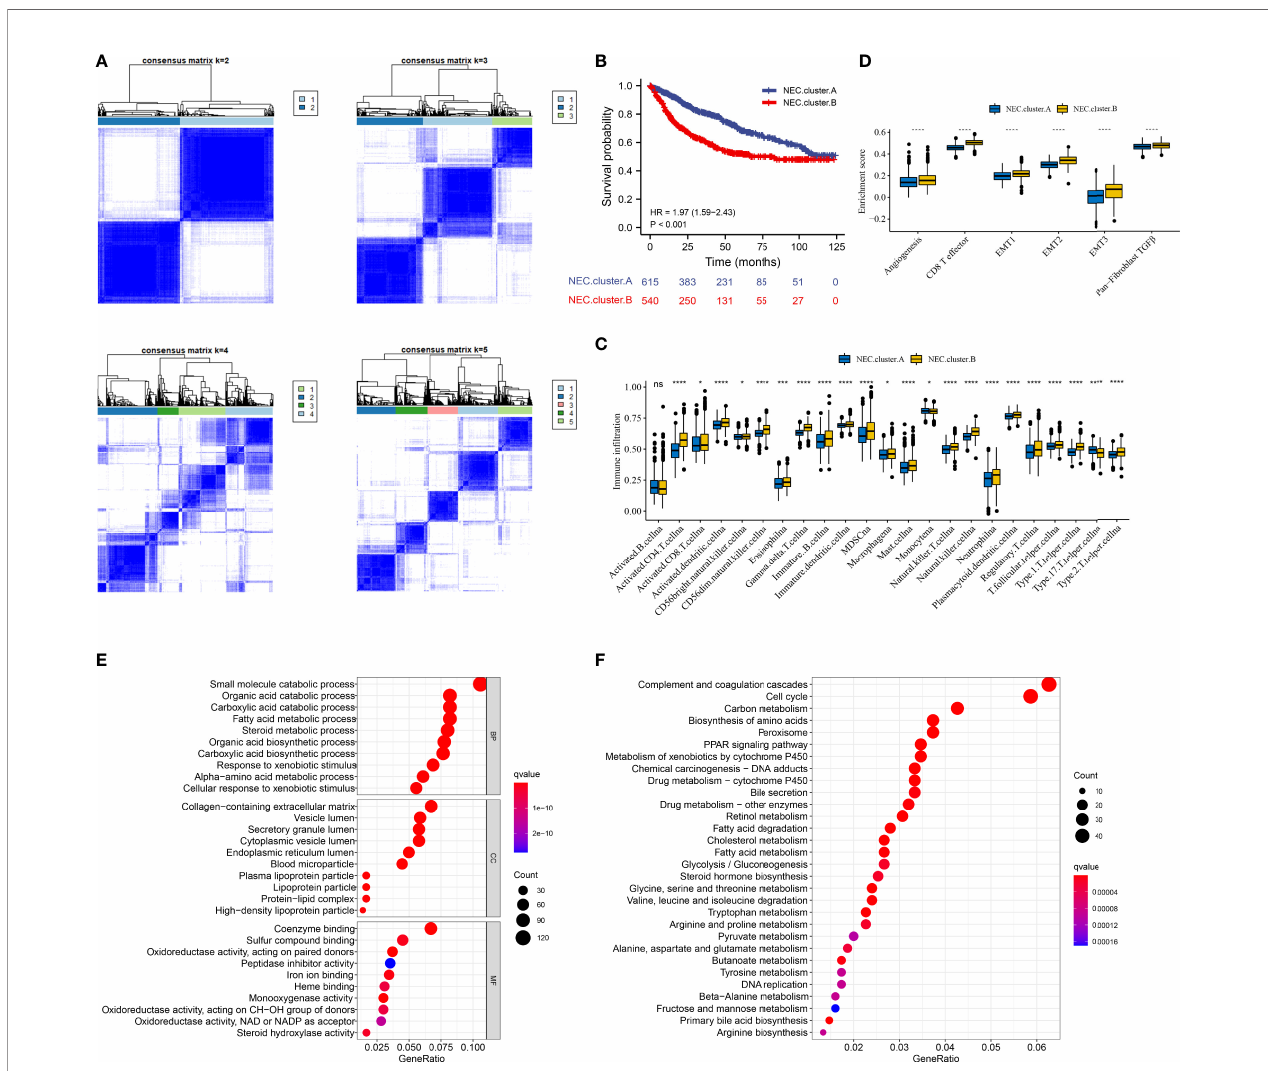
FIGURE 3 | Necroptosis subtypes and biological characteristics of two distinct subtypes of samples divided by consistent clustering. (A) Unsupervised consensus clustering for 1155 HCC patients in a meta cohort (TCGA-LIHC, LIRI-JP, GSE14520, GSE36376, and GSE76427). (B) Survival analyses for the two NEC.clusters based on 1155 patients with HCC from fi ve cohorts (TCGA-LIHC, LIRI-JP, GSE14520, GSE36376, and GSE76427) including 615 cases in NEC.cluster.A (blue), and 540 cases in NEC.cluster.B (red). Kaplan-Meier curves with Log-rank p value < 0.001 showed a signi fi cant survival difference among two modi fi cation patterns. The NEC.cluster.A showed signi fi cantly better overall survival than the NEC.cluster.B. (C) The illustration shown the abundance of 23 immune in fi ltrating cell in NEC.cluster.A (blue) andNEC.cluster.B (yellow). The upper and lower ends of the boxes represented the interquartile range of values. The lines in the boxes represented median value, and black dots showed outliers (Student ’ s t test). The asterisks represented the statistical p-value (*P < 0.05; **P < 0.01; ***P < 0.001; ****P < 0.0001). (D) Differences in stroma-activated pathways including EMT, TGF beta, and angiogenesis pathways among two NEC clusters (Student ’ s t test). The asterisks represented the statistical p-value (*P < 0.05; **P < 0.01; ***P < 0.001; ****P < 0.0001). (E) GO enrichment analysis. (F) KEGG enrichment analysis. The illustration was used to visualize these biological processes, where red represented activated pathways and blue represented inhibited